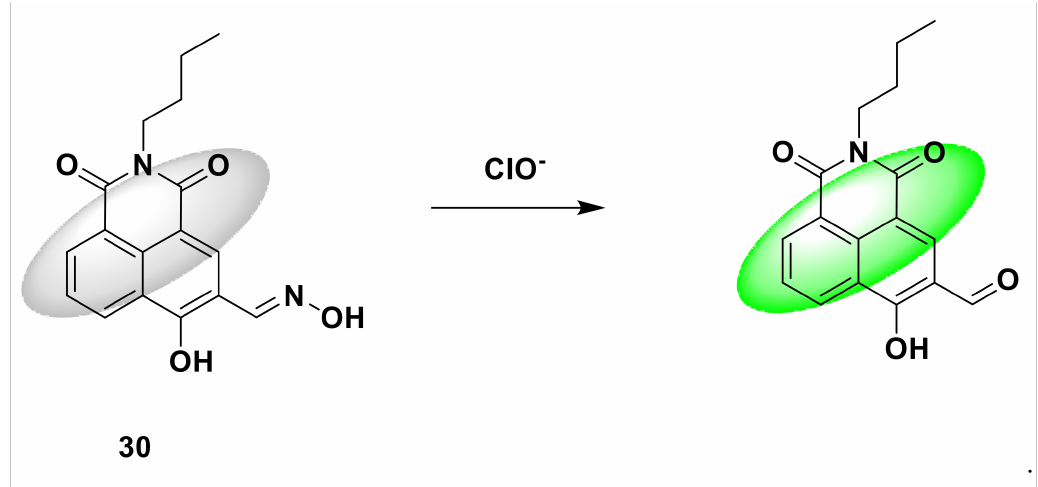
Figure 30. The reaction of probe 30 and ClO −